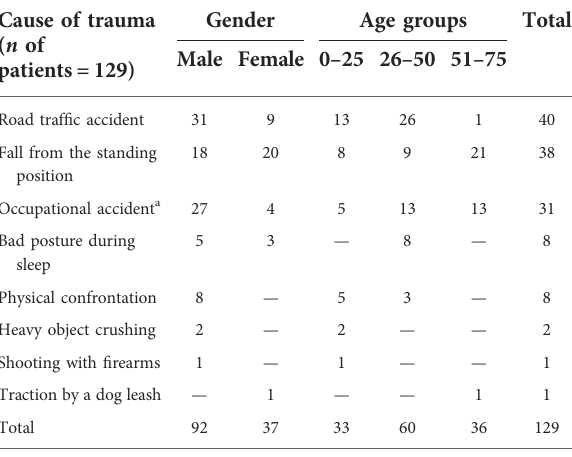
TABLE 4 Location of nerve lesion and other associated injuries.